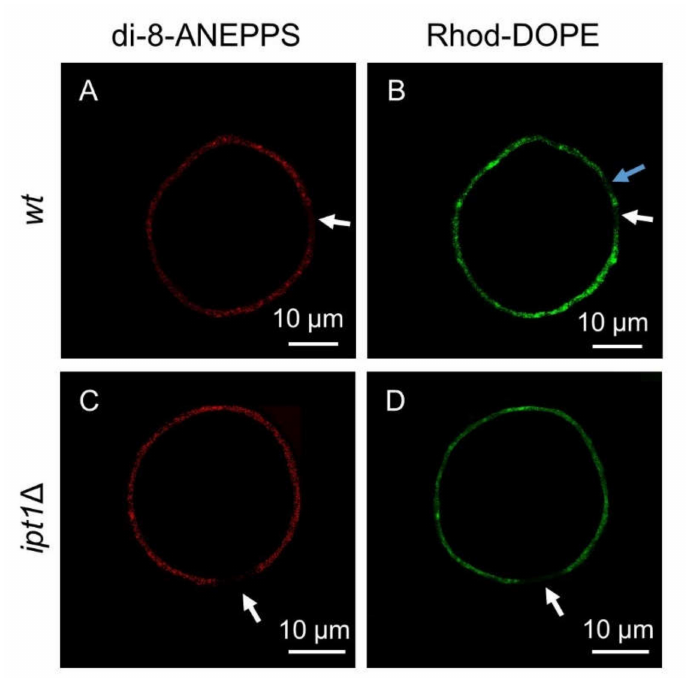
Figure 3. S. cerevisiae plasma membrane lipids have complex phase behavior. Representative confocal microscopy images of giant unilamellar vesicles (GUVs) reconstituted from plasma membrane lipid extracts obtained from wt cells ( A , B ) or ipt1 ∆ cells ( C , D ) double-labelled with both di-8-ANEPPS and Rhod-DOPE. Images from di-8-ANEPPS channel ( A , C ) and Rhod-DOPE channel ( B , D ) are shown. White arrows indicate regions that were poorly labelled by both probes. The blue arrow points